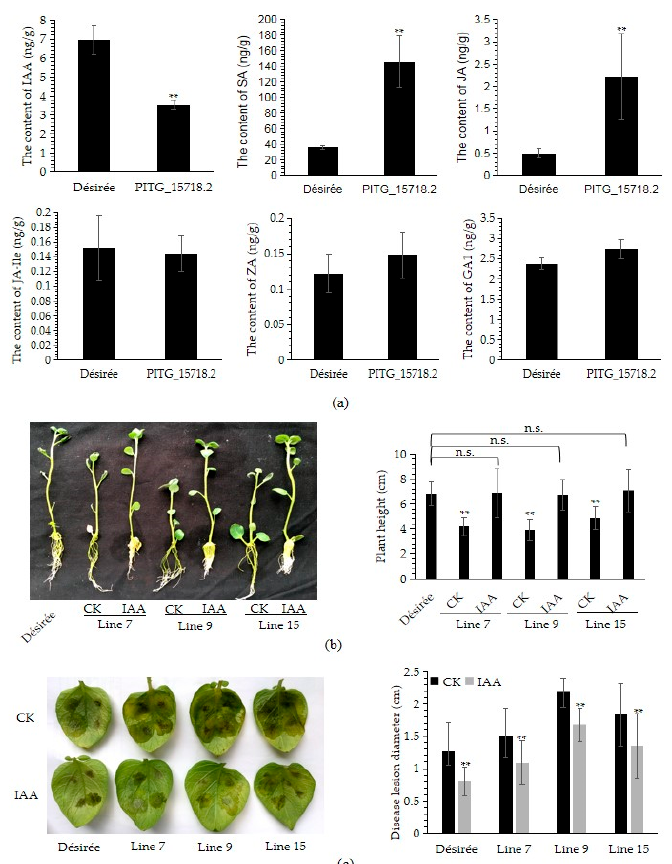
Figure 7. Decreasing of IAA is involved in PITG_15718.2-mediated inhibition of plant immunity and growth. ( a ) The content of salicylic acid (SA), jasmonic acid (JA), Ile-JA, Zeatin (ZA), indole-3-acetic acid (IAA) and gibberellic acid 1 (GA1). The sample was collected from leaves of 3-weeks of potato planting in soil. The sample of PITG_15718.2 was mixed with equal amount of three transgenic lines 7, 9 and 15. Four replicates for each sample were measured by LC-MS. Asterisks indicate extremely significant differences determined using the Student’s t -test ( p < 0.01); ( b ) the plant height of transgenic lines is restored by supplementing with IAA. Images were photographed two weeks after planting. The plant height was measured with at least 20 plantlets. The concentration of IAA is 1 mg/L; ( c ) pre-spraying IAA enhances resistance to P. infestans. Leaves of 3-weeks of potato planting in soil was sprayed with 1 mg/L of IAA and inoculated with P. infestans 24 h later. Images were photographed four days post inoculation and disease lesion diameter were measured with at least 30 leaves. Asterisks indicate extremely significant differences determined using the Student’s t -test ( p < 0.01). The above experiments (b and c) were repeated three times with the similar results.